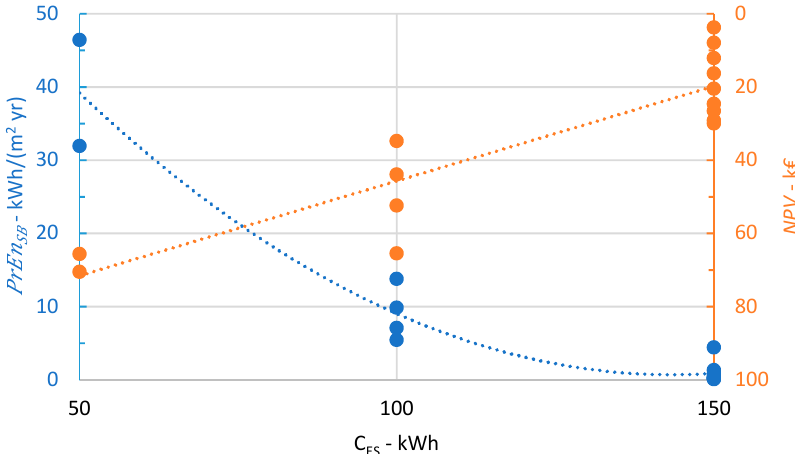
Figure 7. Energy consumption and net present value as a function of the nominal ES energy on the Pareto frontier.